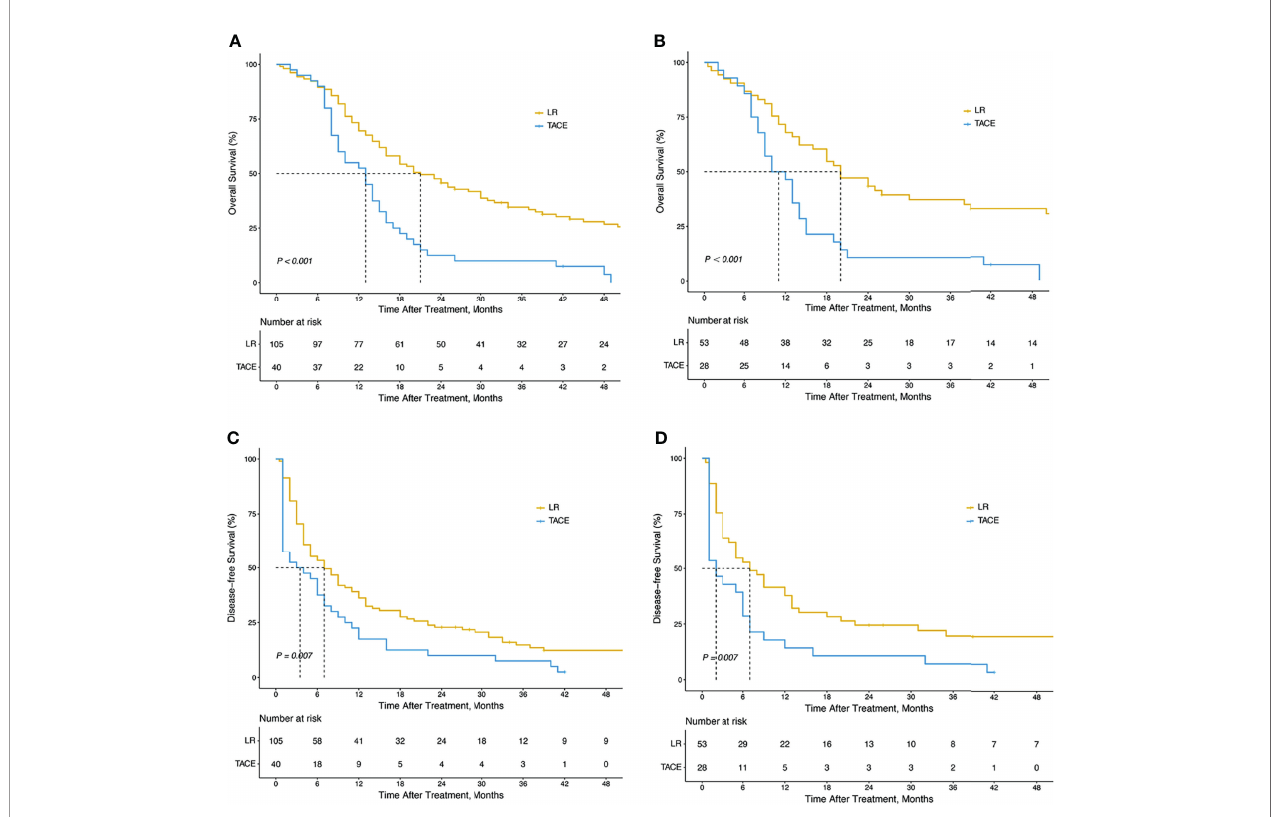
FIGURE 2 | Kaplan – Meier survival curves of OS and DFS in all HCC patients with BDTT. OS for HCC patients with BDTT in the LR and TACE groups (105 patients vs. 40 patients) before PSM (A) (P < 0.001); DFS in the LR and TACE groups (105 patients vs. 40 patients) before PSM (C) (P < 0.001); OS for HCC patients with BDTT in the LR and TACE groups (53 patients vs. 28 patients) after PSM (B) (P = 0.007); DFS in the LR and TACE groups (53 patients vs. 28 patients) after PSM (D) (P = 0.007). OS, overall survival; DFS, disease-free survival; HCC, hepatocellular carcinoma; BDTT, bile duct tumor thrombus; LR, liver resection; TACE, transcatheter arterial